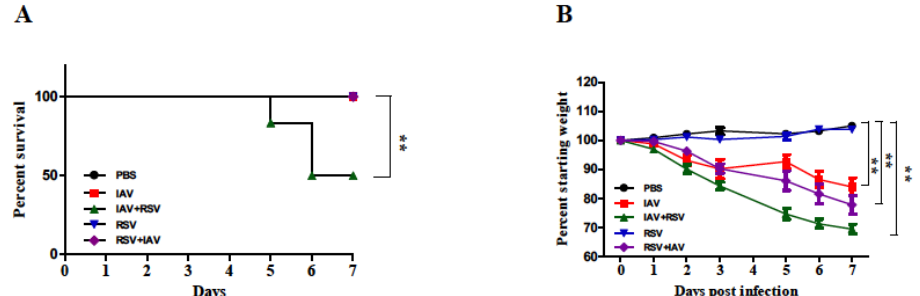
Figure 2. Body weight loss was more severe in mice infected with IAV 24 h prior to RSV inoculation . Mice were infected with IAV PR8, RSV A2 or one after the other, 24 h apart (IAV+RSV and RSV+IAV) and monitored for ( A ) survival and ( B ) body weight changes for 7 days. Mice inoculated with PBS served as the control. Values are mean ± SEM (in percentages) of the daily weight divided by the starting weight for each mouse. Survival data were derived from two independent experi- ments ( n = 6 mice per group). Body weight data were derived from five independent experiments ( n = 18 mice per group). Asterisks denote significant differences between the control and experi- mental groups; (** p < 0.005). Survival analysis was performed by Kaplan – Meier survival curves and a log-rank test, using GraphPad Prism.